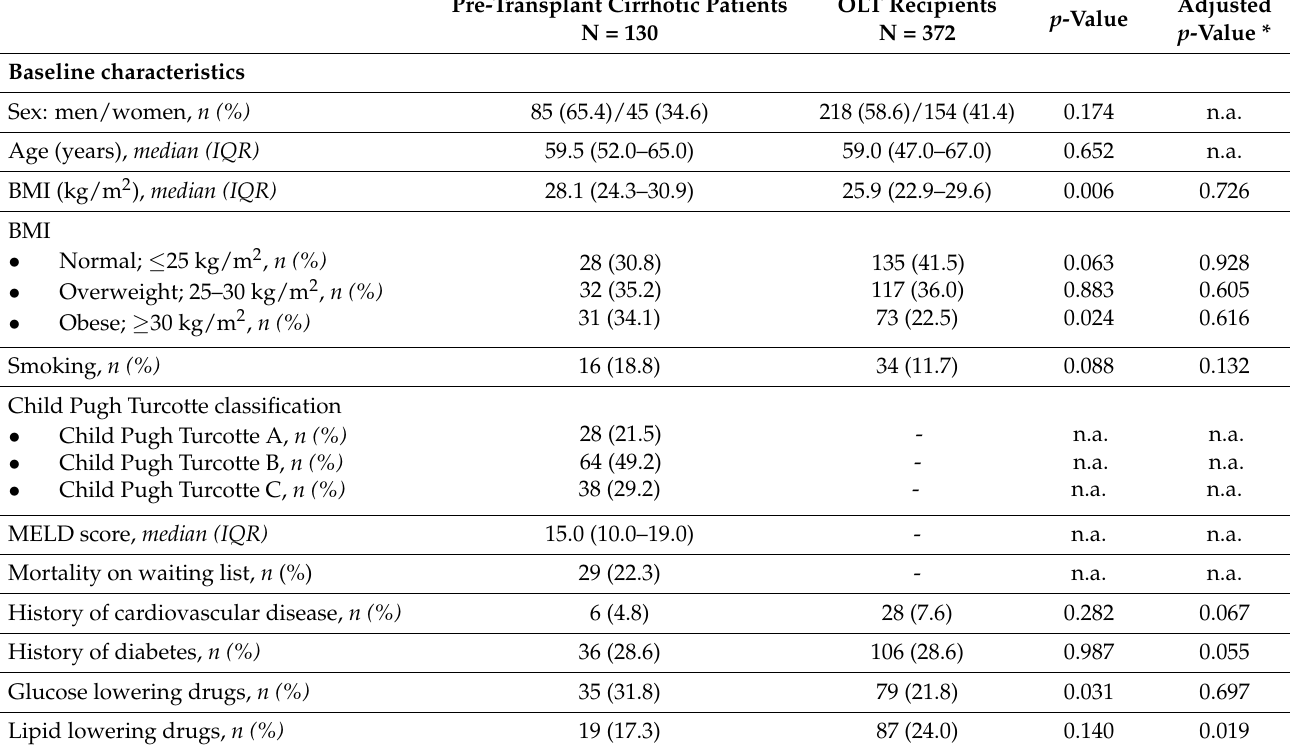
Table 1. Clinical characteristics and lipid profile of 130 pre-transplant cirrhotic patients and 372 orthotopic liver transplant (OLT) recipients from